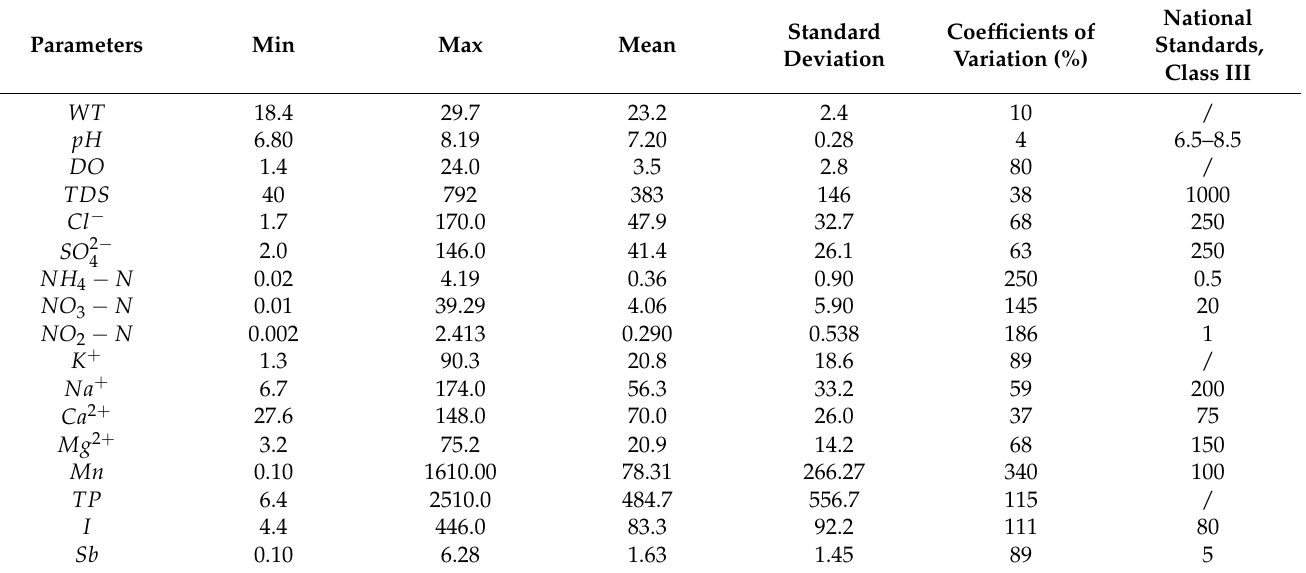
Table 2. Summary statistics of physicochemical parameters in groundwater in the pilot promoter region of Yangtze River Delta integration demonstration